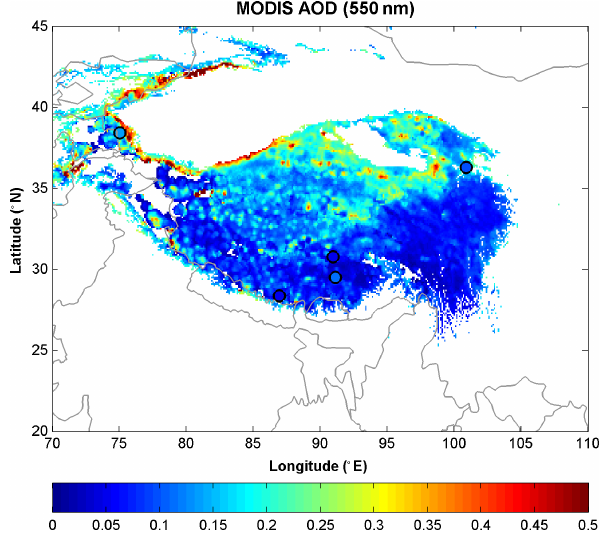
Figure 6. Spatial distribution of MODIS_AOD at 550nm over the Tibetan Plateau (only the altitude > 3000m) during 2006–2017. The color-filled circles are the CE318 observation AOD averages at TP